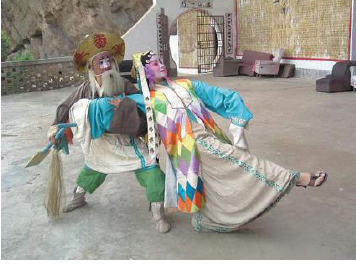
Figure8. Courtyard